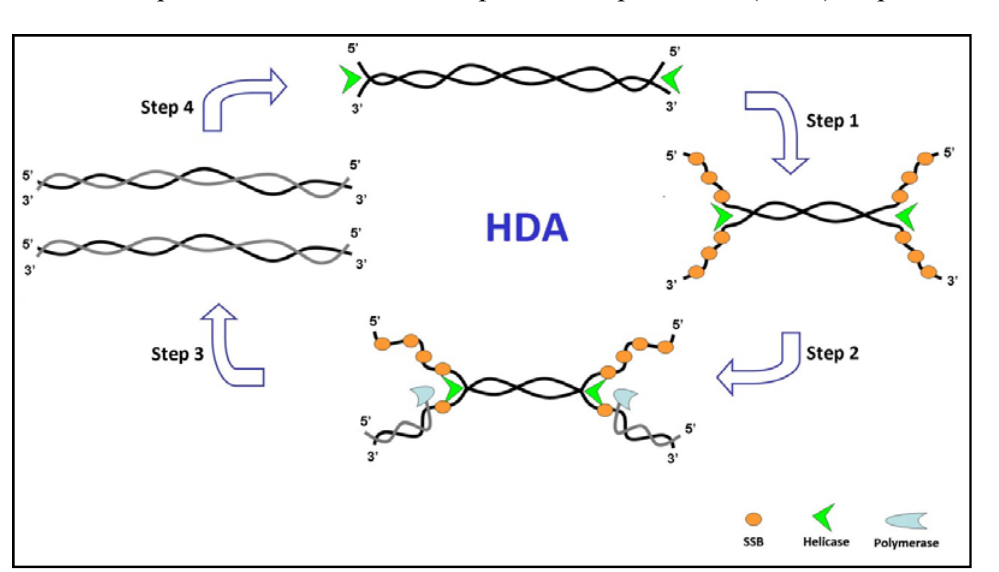
Figure 2. Schematic representation of helicase-dependent amplification (HDA) amplification